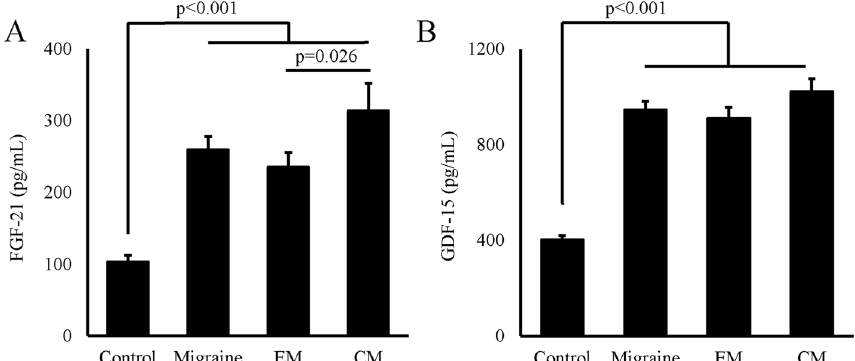
Fig. 1 FGF-21 and GDF-15 values within the different groups. The p < 0.05 was considered statistically significant. CM: Chronic migraine; EM: Episodic